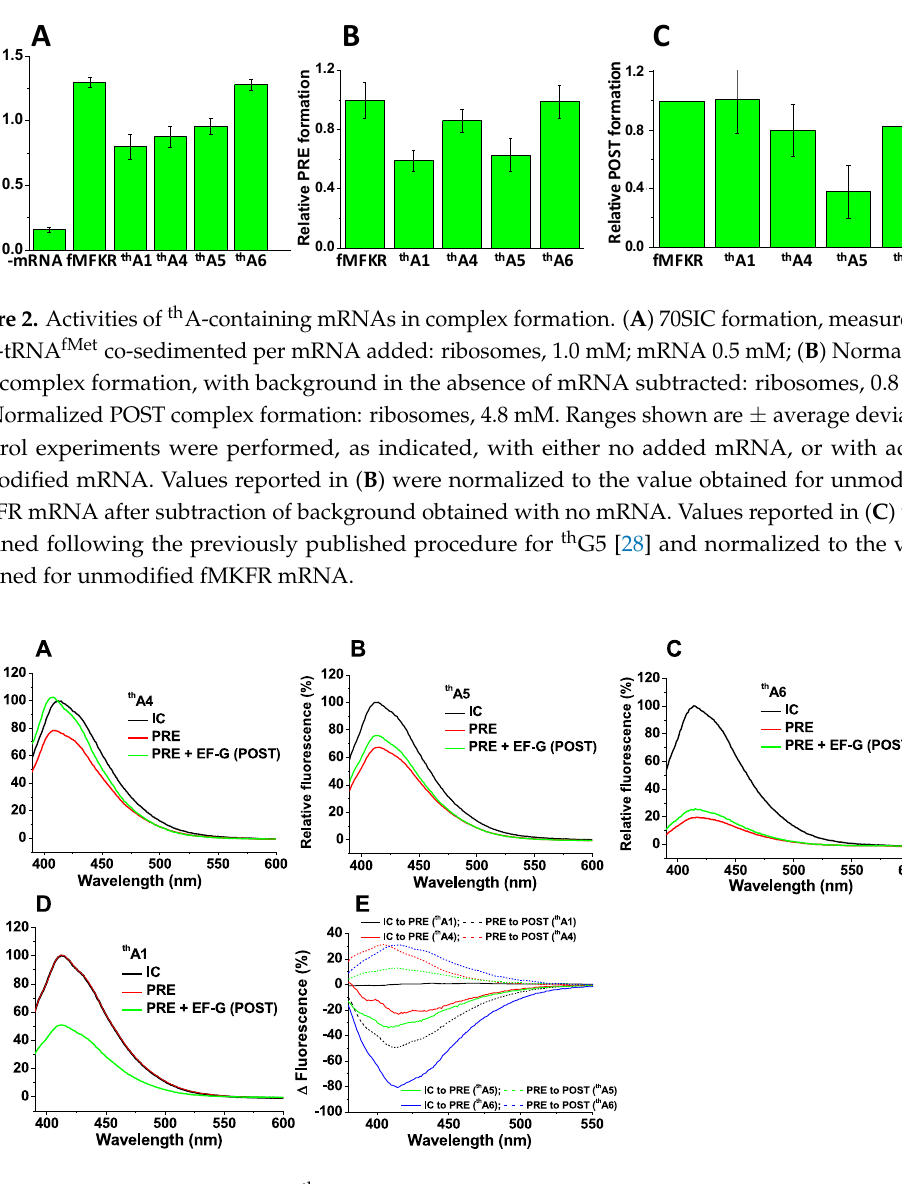
Figure 3. Fluorescence changes of th A-containing mRNAs between ribosomal complex conversion ( A – D ); Traces are shown for purified 70SIC (black); PRE complex (red); POST complex (green); ( E ) Fluorescence intensity changes were obtained by subtracting the spectrum of a purified complex (70SIC or PRE) from the spectrum of a complex prepared in situ (PRE or POST, respectively) and then normalizing the intensity differences to the peak intensity value of purified complex (70SIC or PRE, respectively).